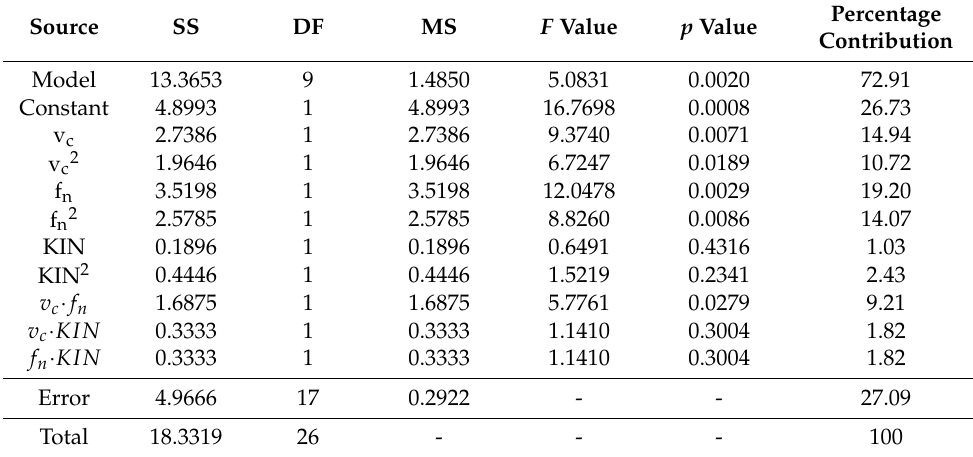
Table 9. ANOVA results for the diameter